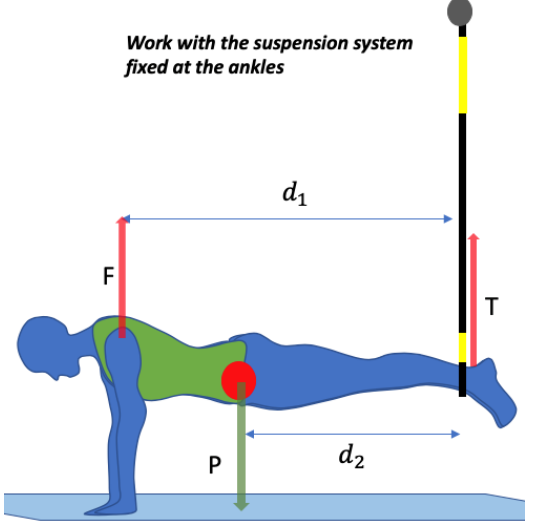
Figure 5. Force system when the subject is suspended by the ankles.